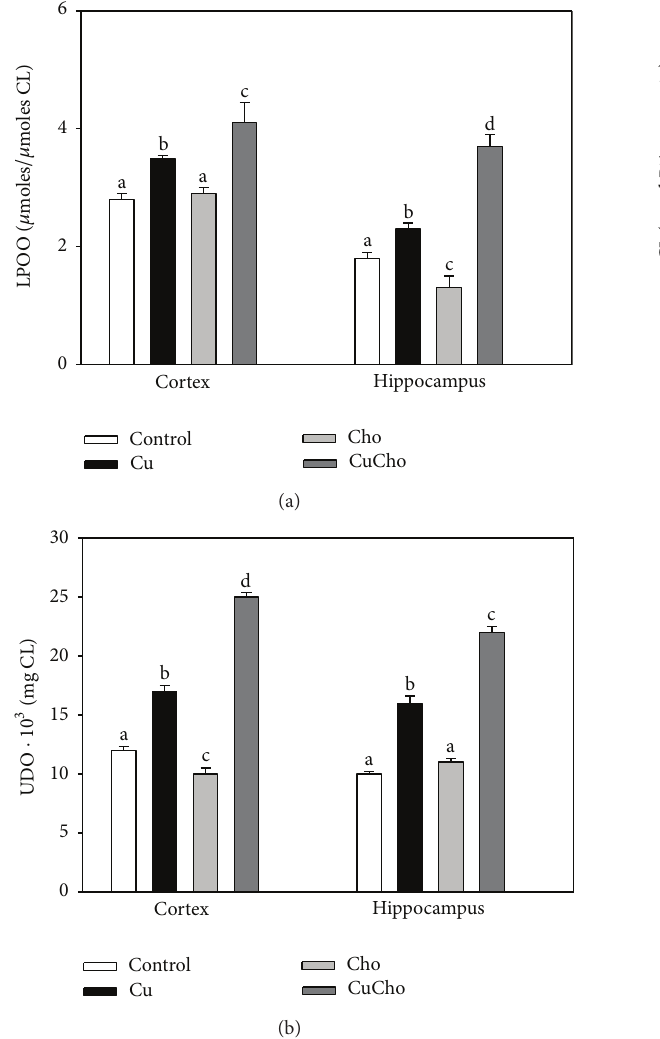
Figure 6: Cardiolipin (CL) (a) and lyso-CL (LCL) (b) levels in mito- chondrial fractions from brain cortex and hippocampus ( 𝜇 moles of Pi/mg total protein). Treatments are indicated with different colors, control (white bars), Cu (black bars), Cho (gray bars), and CuCho (dark gray bars). Samples were analyzed as indicated in Section 2.7. Results are the mean of 10 rats assayed in triplicate ± standard deviation (SD). Significant differences among the experimental groups are indicated with superscript letters (values with distinct letters are significantly different between them, 𝑃 < 0.01